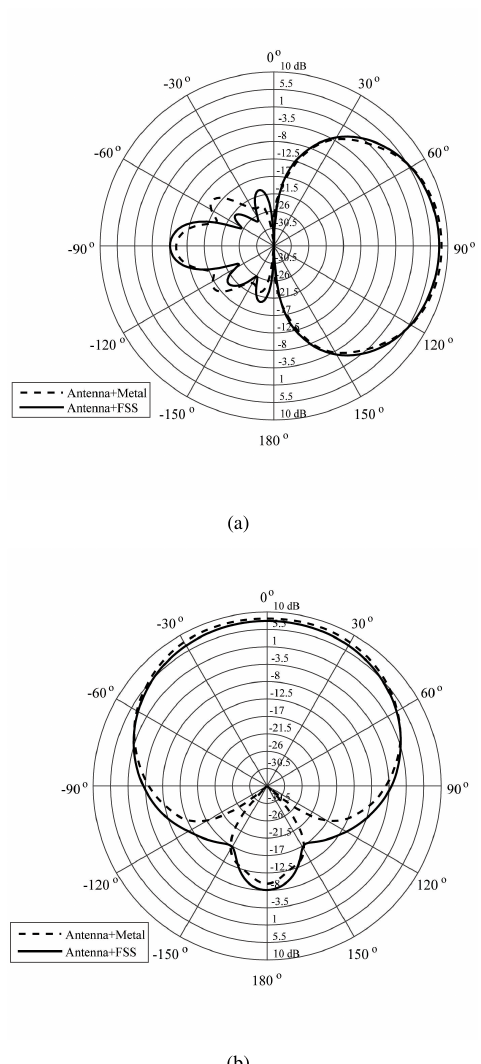
Figure 5: Radiation pattern for the antenna on both config- urations at φ = 0 (a), and θ = 90